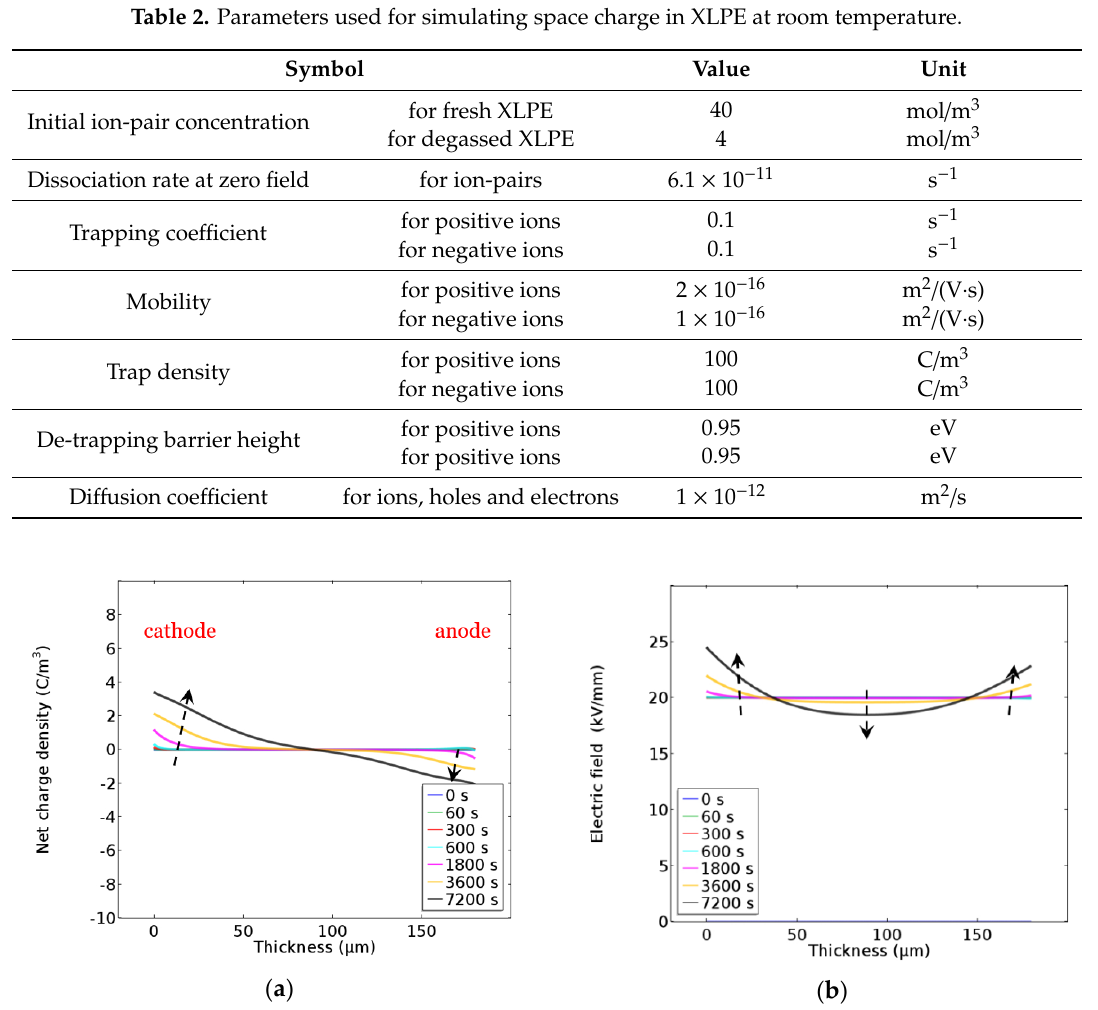
Figure 9. ( a ) Simulated space charge accumulation evolving with time in fresh XLPE samples at 20 kV / mm field under room temperature. ( b ) Calculated electric field distribution across the fresh XLPE sample.